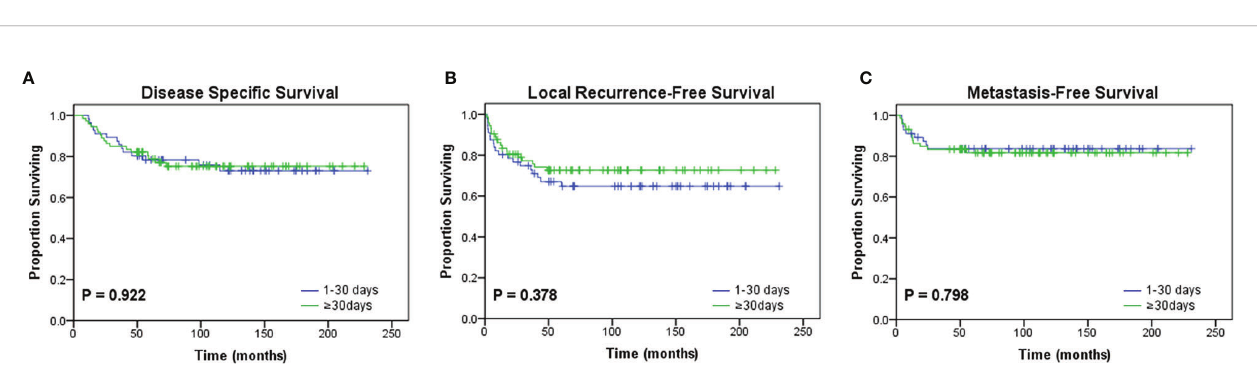
FIGURE 2 | Kaplan-Meier curves showing the (A) disease-speci fi c survival (p = 0.046), (B) local recurrence-free survival (p = 0.334), and (C) metastasis-free survival (p = 0.029) of patients after initial unplanned excision based on the presence or absence of residual tumor in the re-excision specimen.